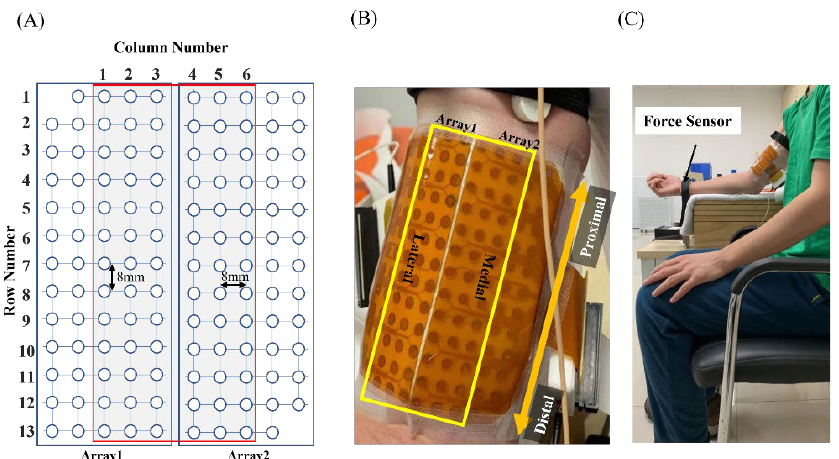
Figure 3. ( A ) Schematic representation of the two adhesive 2D matrices for experimental signals. ( B ) High-density electrode matrix consisting of a grid with 6 columns (that are positioned parallel to the muscle fiber direction) and 13 rows. ( C ) Illustration of the experimental setup.